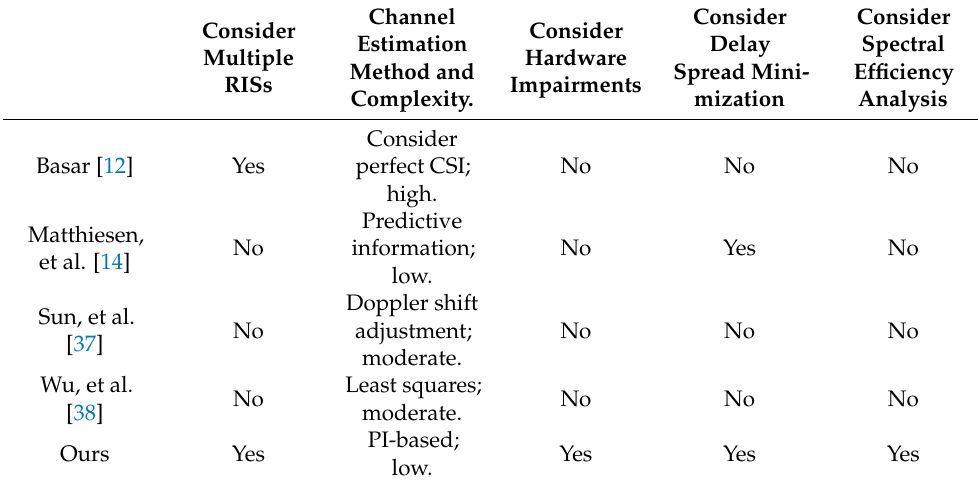
Table 1. State-of-the-art RIS-assisted high-speed